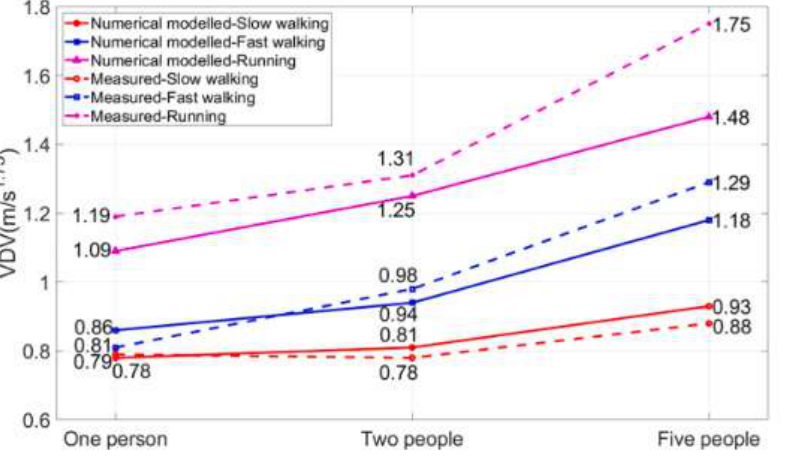
Figure 8. VDVs of the one-way CLT floor in experimental testing and numerical modelling prepared by Wang et al. [45]. Reproduced with permission.